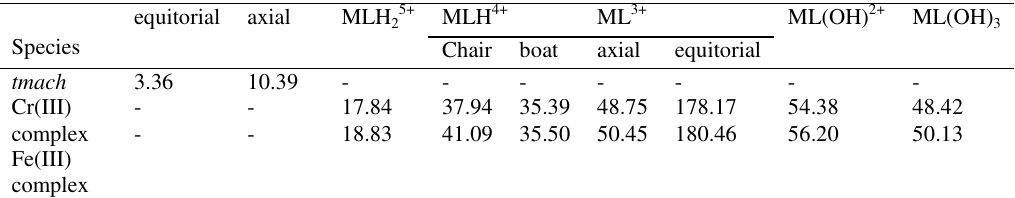
Table 2 . Strain energy (kcal/mole) of MLH 25+ , MLH 4+ , ML 3+ , ML(OH) 2+ , ML(OH) 3 obtained from MM + calculation: MLH 4+ ML 3+ equitorial axial MLH 25+ Species Chair boat axial equitorial